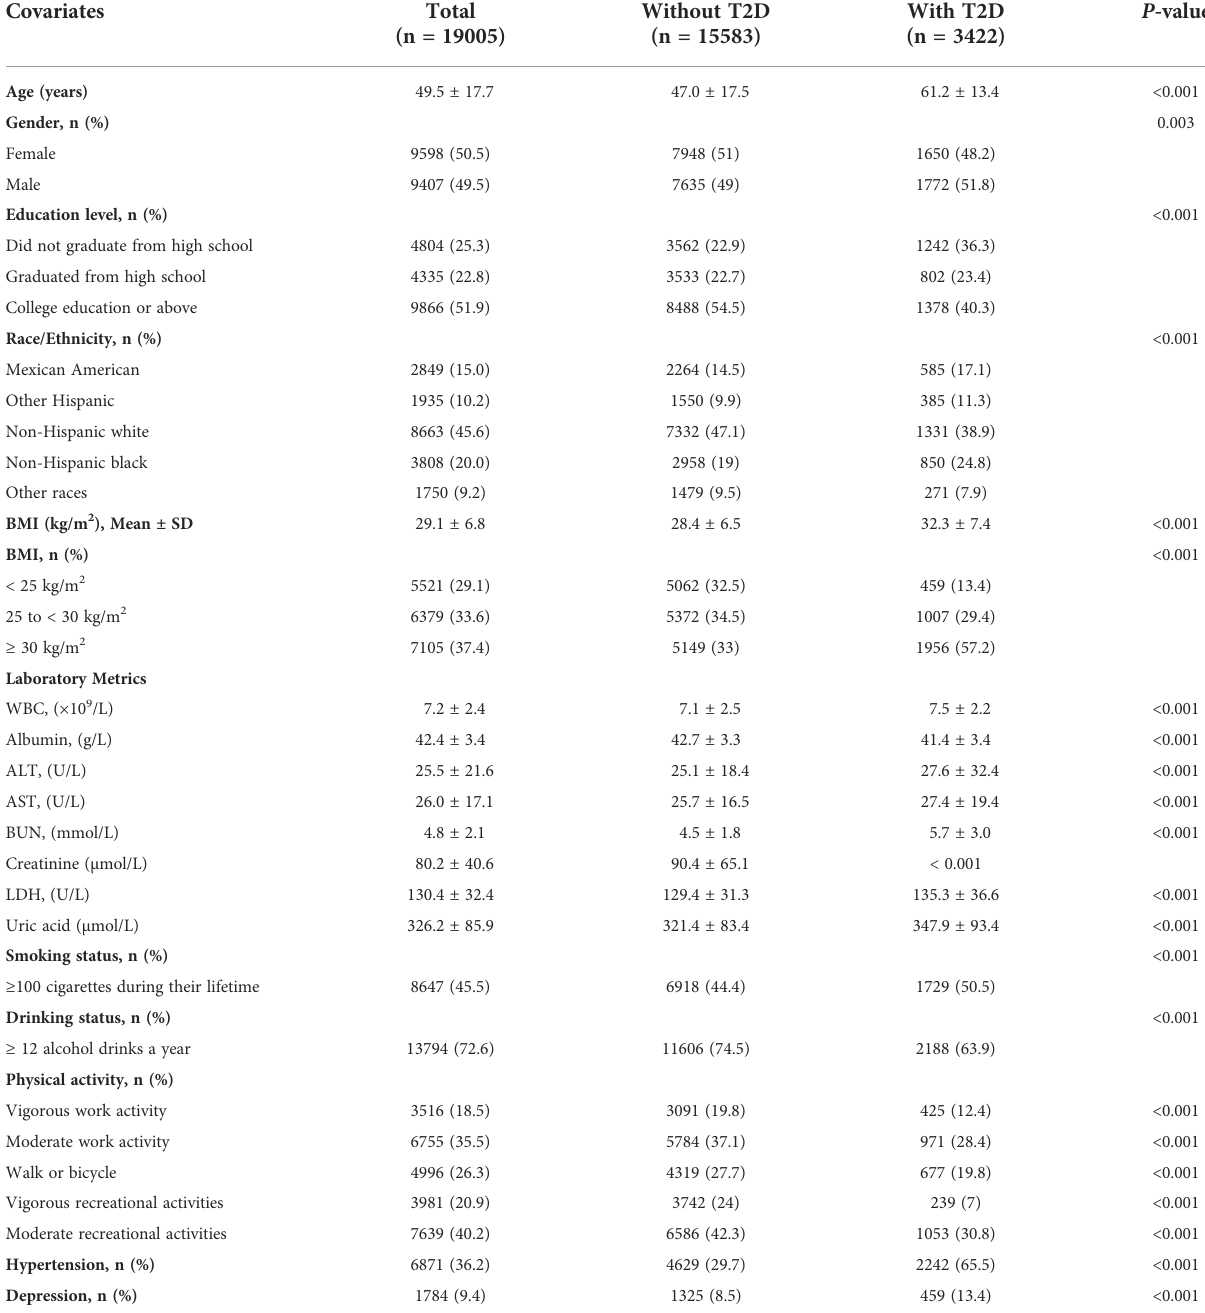
TABLE 1 Baseline characteristics of